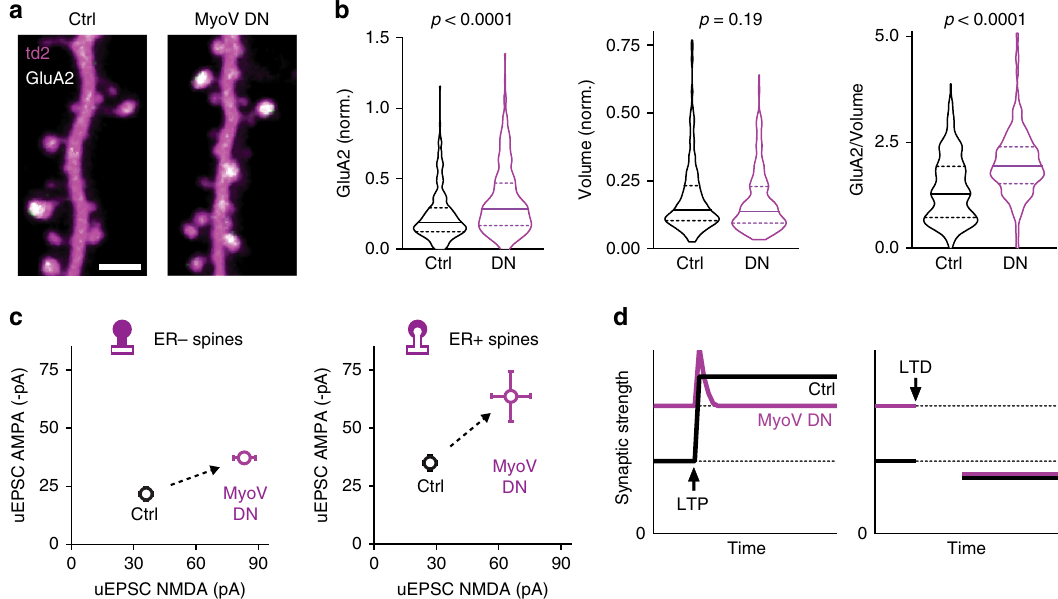
Fig. 4 Blocking ER motility leads to high potency synapses. a Two-photon images showing distribution of SEP-GluA2 receptors in dendritic spines of control and MyoV DN-expressing CA1 neurons. Scale bar: 2 µ m. This experiment was repeated in 4 slice cultures. b Violin plots showing median (solid horizontal line) and quartiles (dashed horizontal lines) of SEP-GluA2 content (median 0.19 vs 0.29, p < 0.0001, Mann – Whitney test), spine head volume (0.143 vs 0.137, p = 0.2, two-sided Mann – Whitney test), and SEP-GluA2 concentration (1.28 vs 1.93, p < 0.0001, two-sided Mann – Whitney test) in dendritic spines of control ( n = 266 spines, 4 neurons, 2 slices) and MyoV DN-expressing CA1 neurons ( n = 314, 4 neurons, 2 slices). c Uncaging-evoked AMPA-EPSCs recorded at − 70 mV were larger at synapses of MyoV DN-expressing neurons (Ctrl ER − 21.7 ± 2.9 pA, n = 16 spines vs MyoV DN ER − 37.2 ± 2.5 pA, n = 58 spines, p = 0.0009, two-sided Mann – Whitney test; Ctrl ER + 35.0 ± 3.2 pA, n = 17 spines vs MyoV DN ER + 63.6 ± 10.7 pA, n = 10 spines, p = 0.0018, two-sided Mann – Whitney test). Uncaging-evoked NMDA-EPSCs recorded at + 40 mV were also larger at synapses of MyoV DN- expressing neurons (Ctrl ER − 36.0 ± 3.1 pA, n = 16 spines vs MyoV DN ER − 83.2 ± 5.3 pA, n = 58 spines, p < 0.0001, two-sided Mann – Whitney test; Ctrl ER + 26.9 ± 3.0 pA, n = 17 spines vs MyoV DN ER + 65.8 ± 9.3 pA, n = 10 spines, p < 0.0001, two-sided Mann – Whitney test). Markers show mean ± SEM. d Combining the information about baseline strength (uEPSC AMPA) and long-term plasticity suggests that MyoV DN expression did not change the dynamic range of synapses. Source data are provided as a Source Data fi